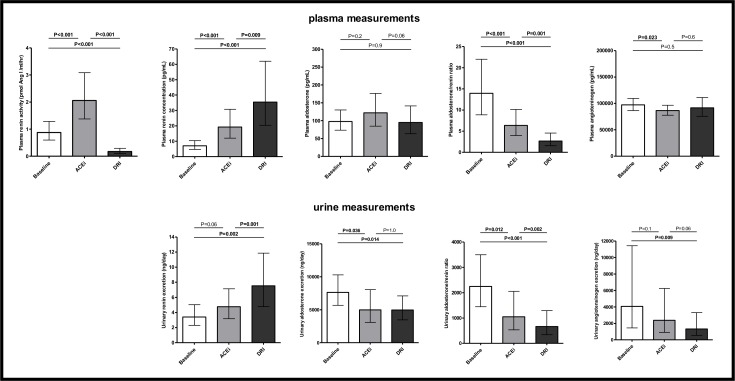
RAAS parameters in plasma (upper panel) and urine (lower panel) at baseline and after 6-week treatment with ACEi and DRI.Data shown as geometric mean (95% CI).